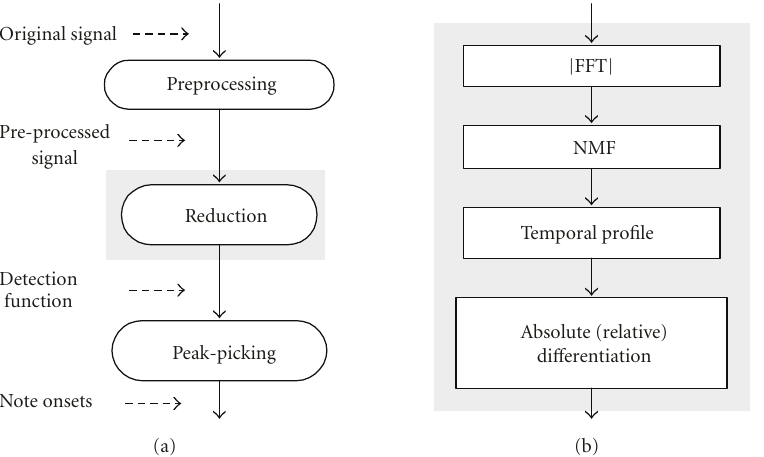
Figure 1: Diagram of the onset detection: (a) the general scheme, (b) the proposed reduction strategy, that is, the scheme for deriving the detection functions in this